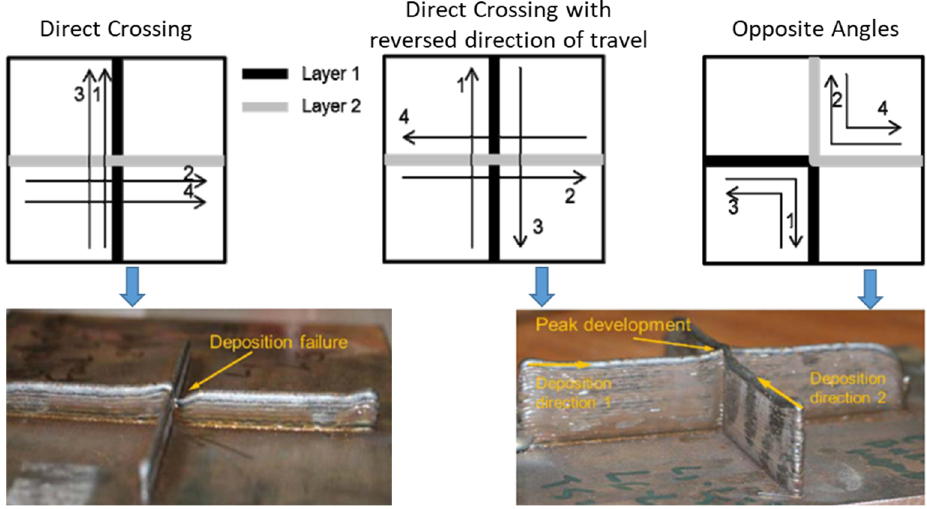
Figure 8. Examples of intersection crossing (adapted from [23]) .